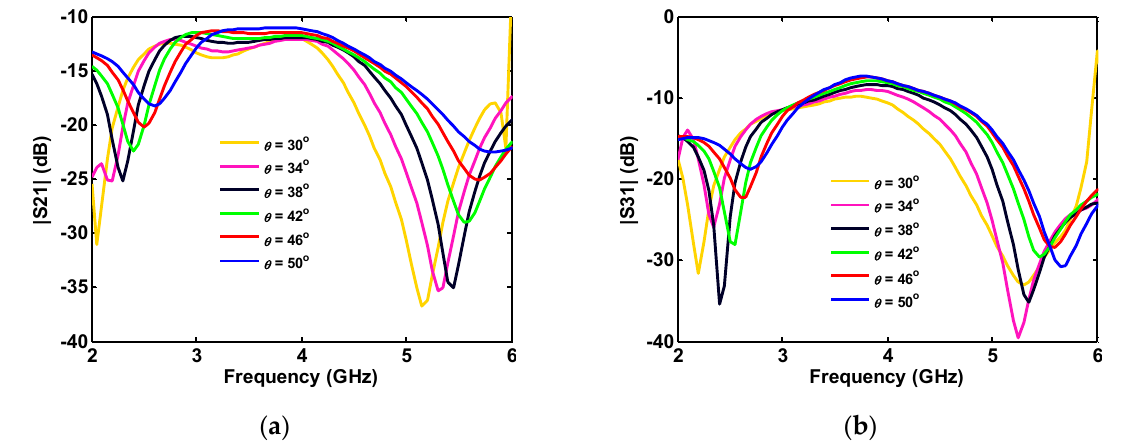
Figure 13. Effect of ground plane angle θ on the simulated isolation (a) S 21 and (b) S 31 between different ports of four-port antenna.